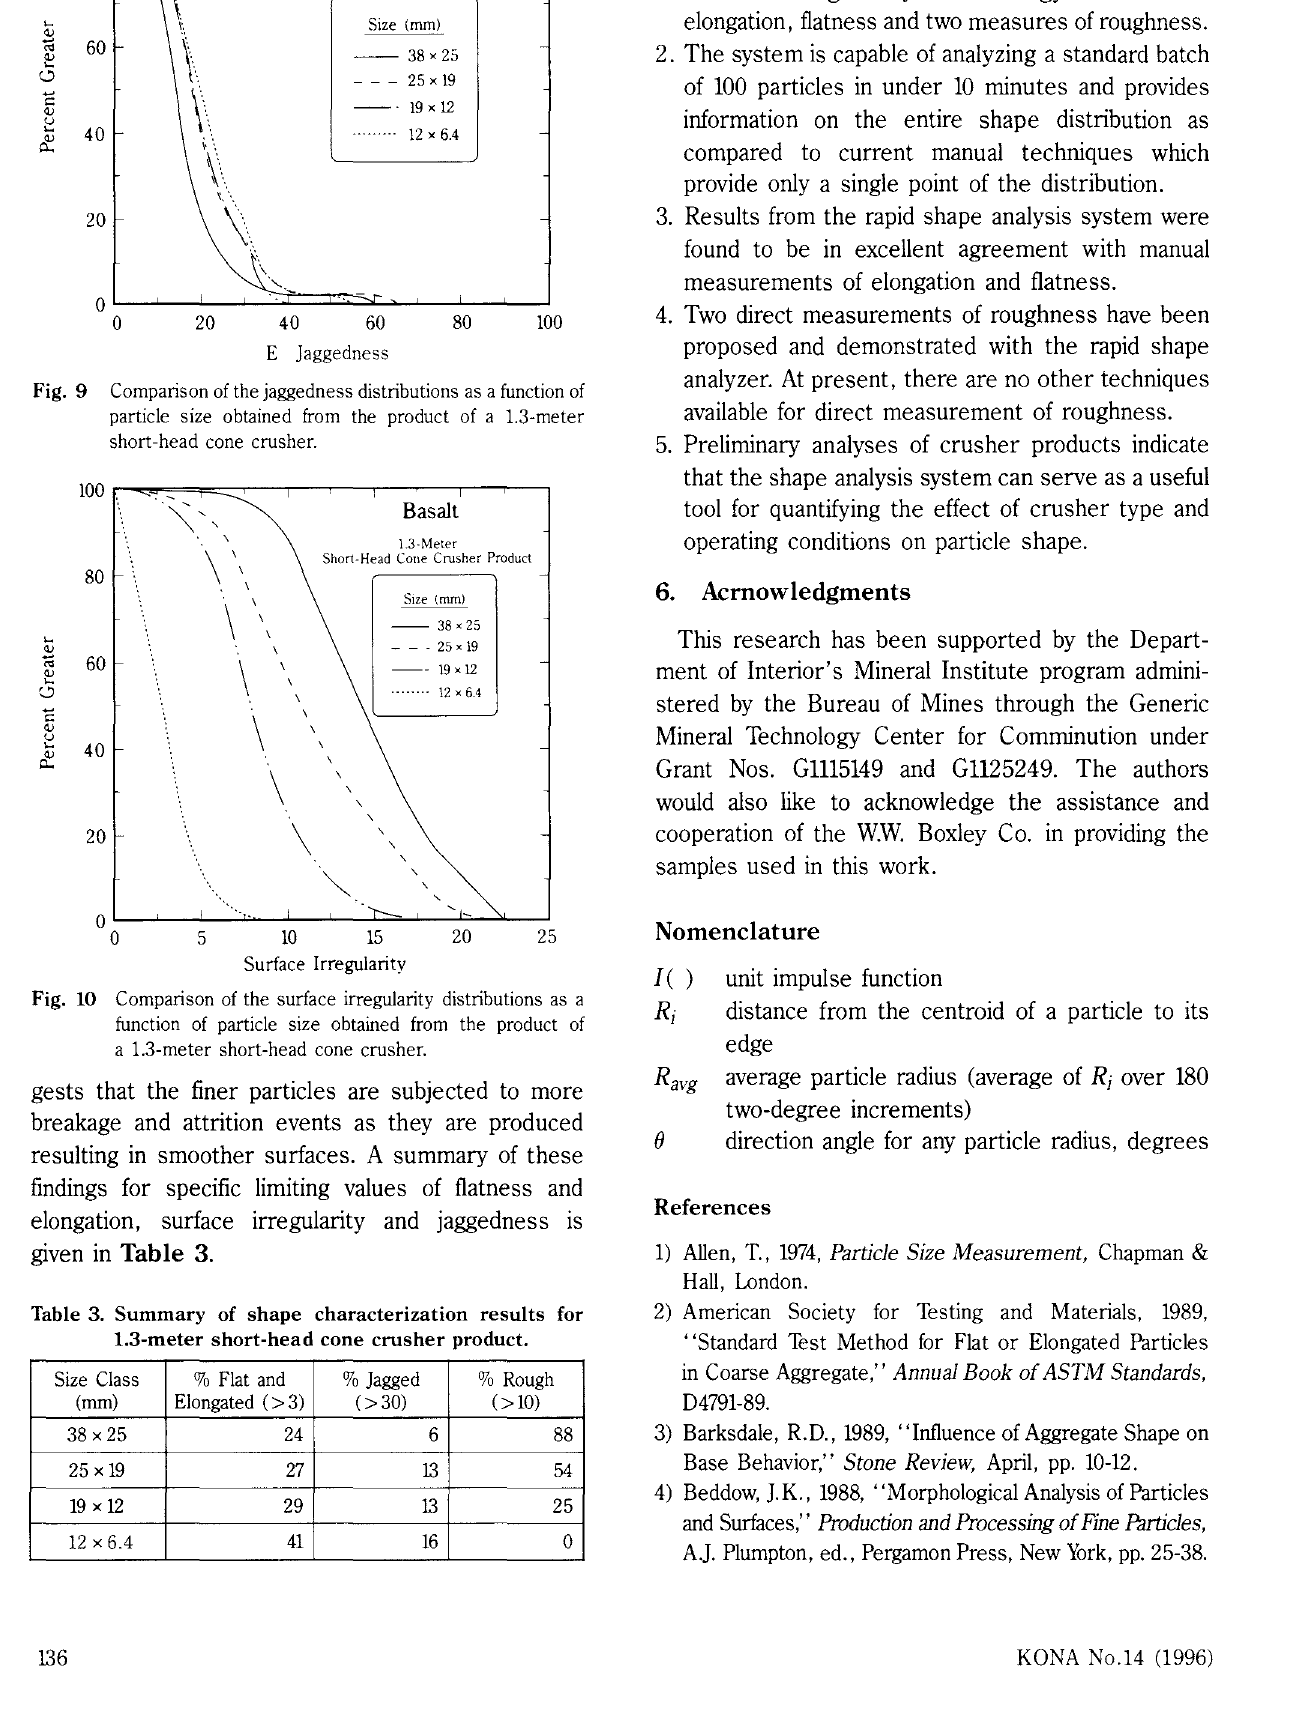
Fig. 9 Comparison of the jaggedness distributions as a function of particle size obtained from the product of a 1.3-meter short -head cone crusher.